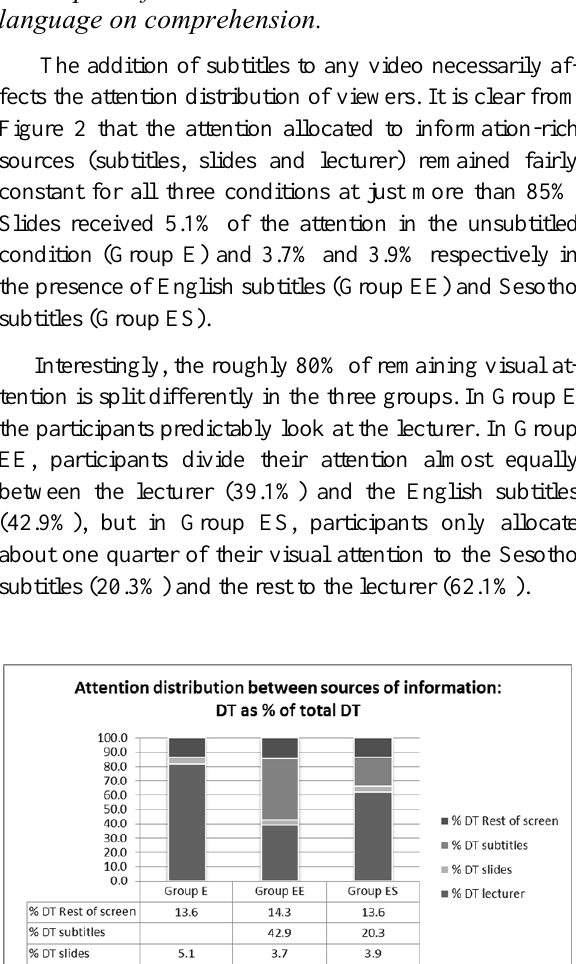
-3.28, p<0.05). Figure 3 illustrates the difference in